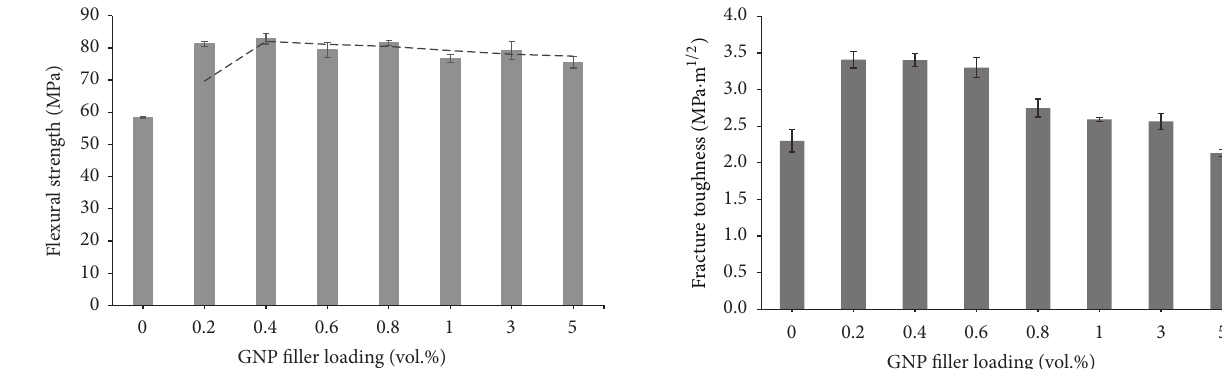
Figure 4: Fracture toughness of GNP filled epoxy